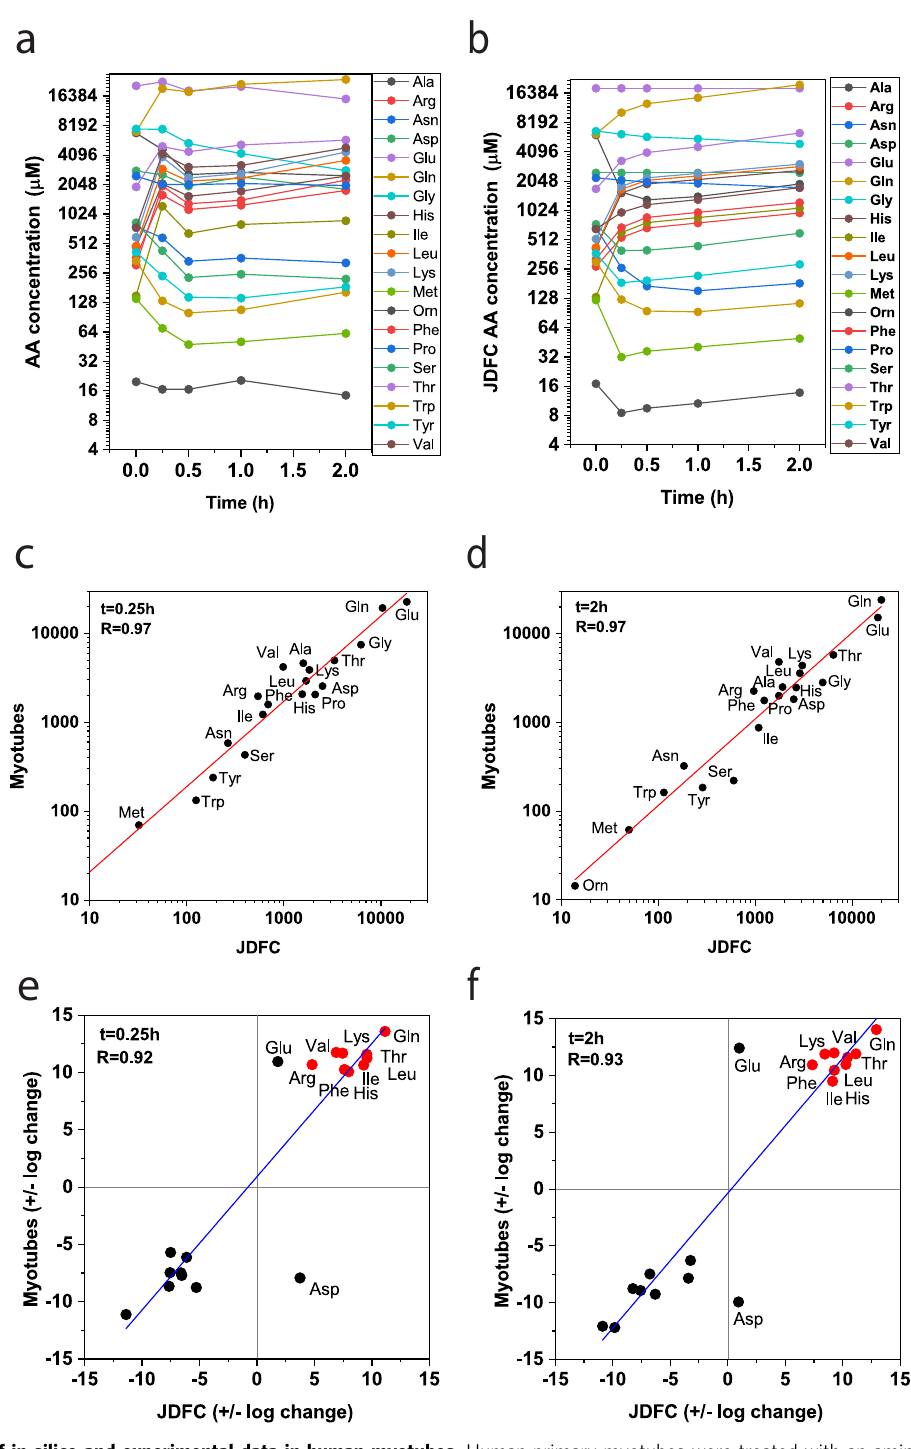
Fig. 7 Comparison of in silico and experimental data in human myotubes. Human primary myotubes were treated with an amino acid mixture corresponding to the constituent amino acids of AXA2678 for 2 h ( n = 3, e = 3). a Cytosolic amino acid concentrations were determined by LC-MS before addition of amino acid mixtures and for 2 h after addition. Cell volume was determined by morphometry. The same initial concentrations were used for JDFC and the simulation was run for 3200 cycles ( b ). c , d Correlation of experimental and simulated data after t = 0.25 h, R = 0.97 ( c ) and t = 2 h, R = 0.97 ( d ). e , f Correlation analysis of changes using a quadrant chart plotting the log t = 0.25 h, R = 0.92 ( e ) and t = 2 h, R = 0.93 ( f ). Spiked 2 change at amino acids are shown as red